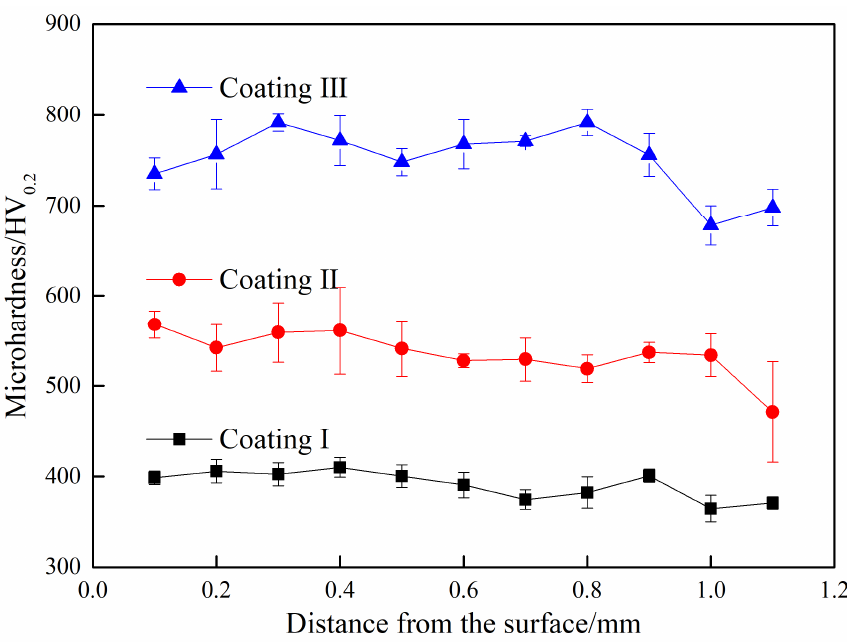
Figure 4. The microhardness distribution along the cross-section of the coatings.